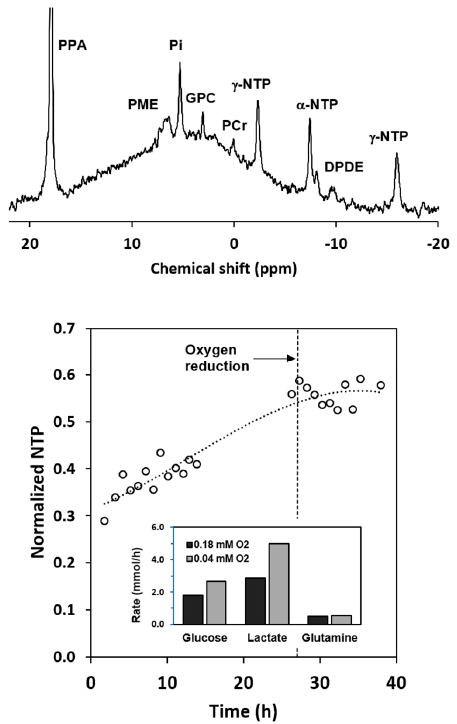
Figure 4. 31 P NMR results for the axial flow experiment summarized in Figure 3. The spectrum at the top of the figure was obtained with 2400 scans at the end of the normoxic period. The time course for the nucleoside triphosphates is shown in the bottom of the figure. Reduction of the inlet medium oxygen level from 0.18 mm to 0.04 mM halted the increase in the NTP level. The glucose and lactate results indicate that reduction of the oxygen level resulted in a metabolic shift toward anaerobic glycolysis.